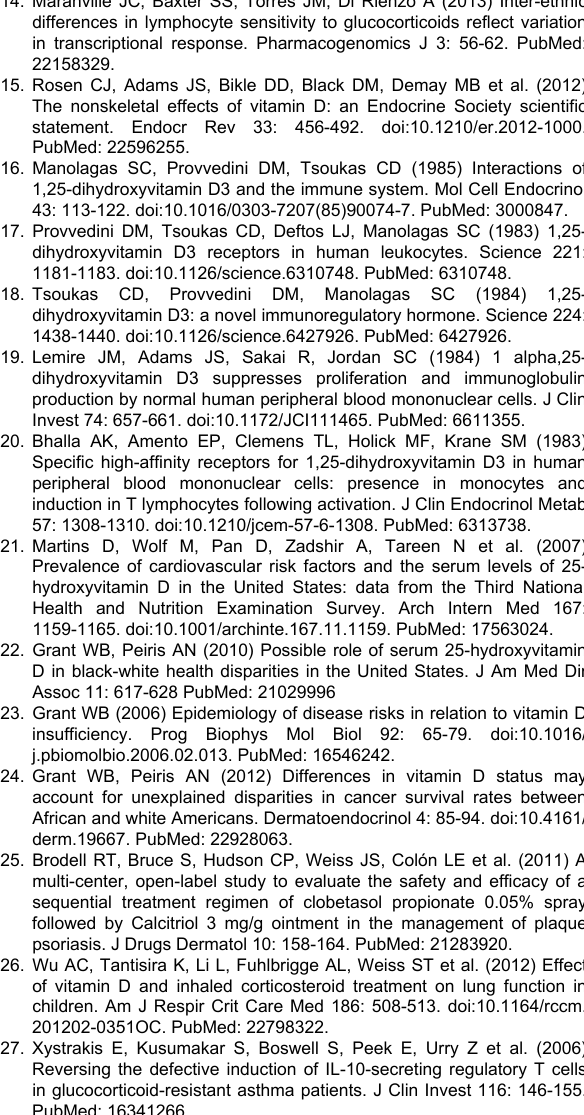
Table S8. Network analysis of downregulated genes only in response to vitamin D treatment at 24